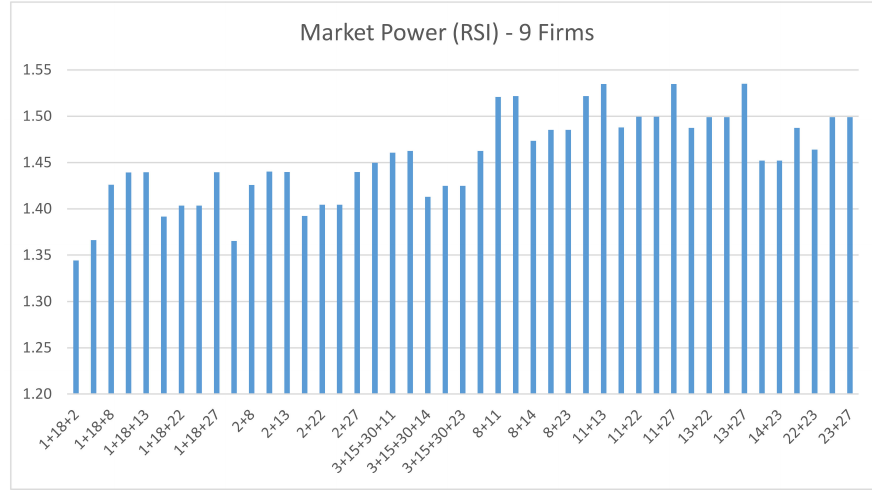
Figure 17. RSI for 9 firms’ setting (Cournot).